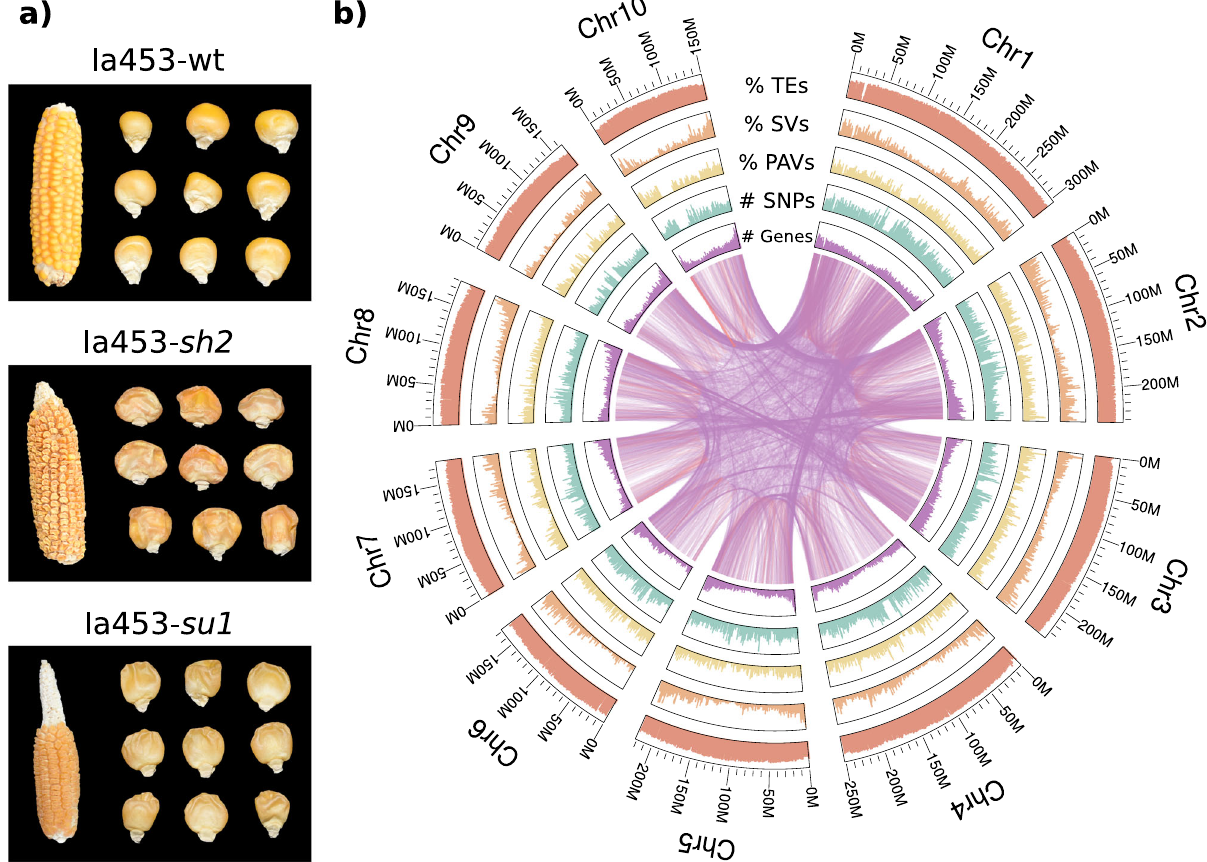
Fig. 1 Appearance of sweet corn in Ia453 isolines and Ia453- sh2 genomic features. a Visual ear appearance of sweet corn in Ia453 isolines, including wild-type (top), the su1 mutation (bottom), and sh2 mutation (center). b Ia453- sh2 genomic features. Outer-to-inner tracks indicate the following: transposable-elements (TEs) (fraction of TEs per 1 Mb window); large structural variations (SVs) with length between 100 and 100,000 bps (fraction of SVs per 1 Mb window) relative to B73 v4; presence and absence variants (PAV) (fraction of PAVs per 1 Mb window) relative to B73 v4; single nucleotide polymorphisms (SNPs) (number of SNPs per 1 Mb window) relative to B73 v4; gene density (number of genes per 1 Mb window); and synteny with lines representing paralogous gene pairs between and within pseudochromosomes in Ia453- sh2 (purple and orange